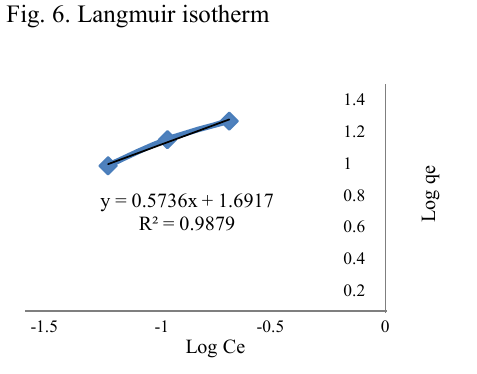
Fig. 7. Freundlich isotherm